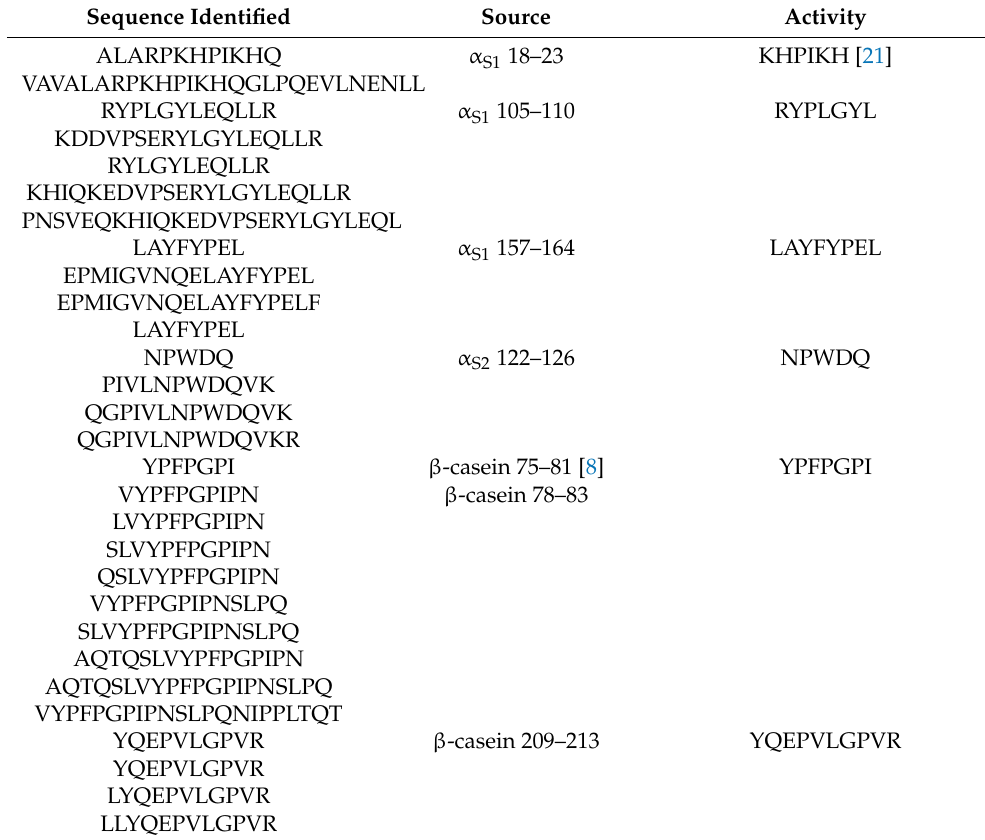
Figure 1. Effect of casein hydrolysate on B lymphocytes stimulation. ( A ) B lymphocyte proliferation activities of peptides after 24 h. ( B ) Effect of casein hydrolysis on secretions of TNF- α in B lymphocyte. In the figure: CH-Casein hydrolysate, PH-Permeate hydrolysate, EH-Entrapment hydrolysate. Data are presented as the mean ± SD ( n = 6). ns, p > 0.05; *, p < 0.05; ***, p < 0.001 versus control group.